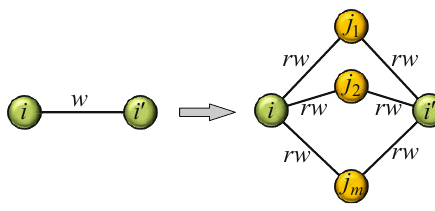
Figure 1: A weighted edge multi - division